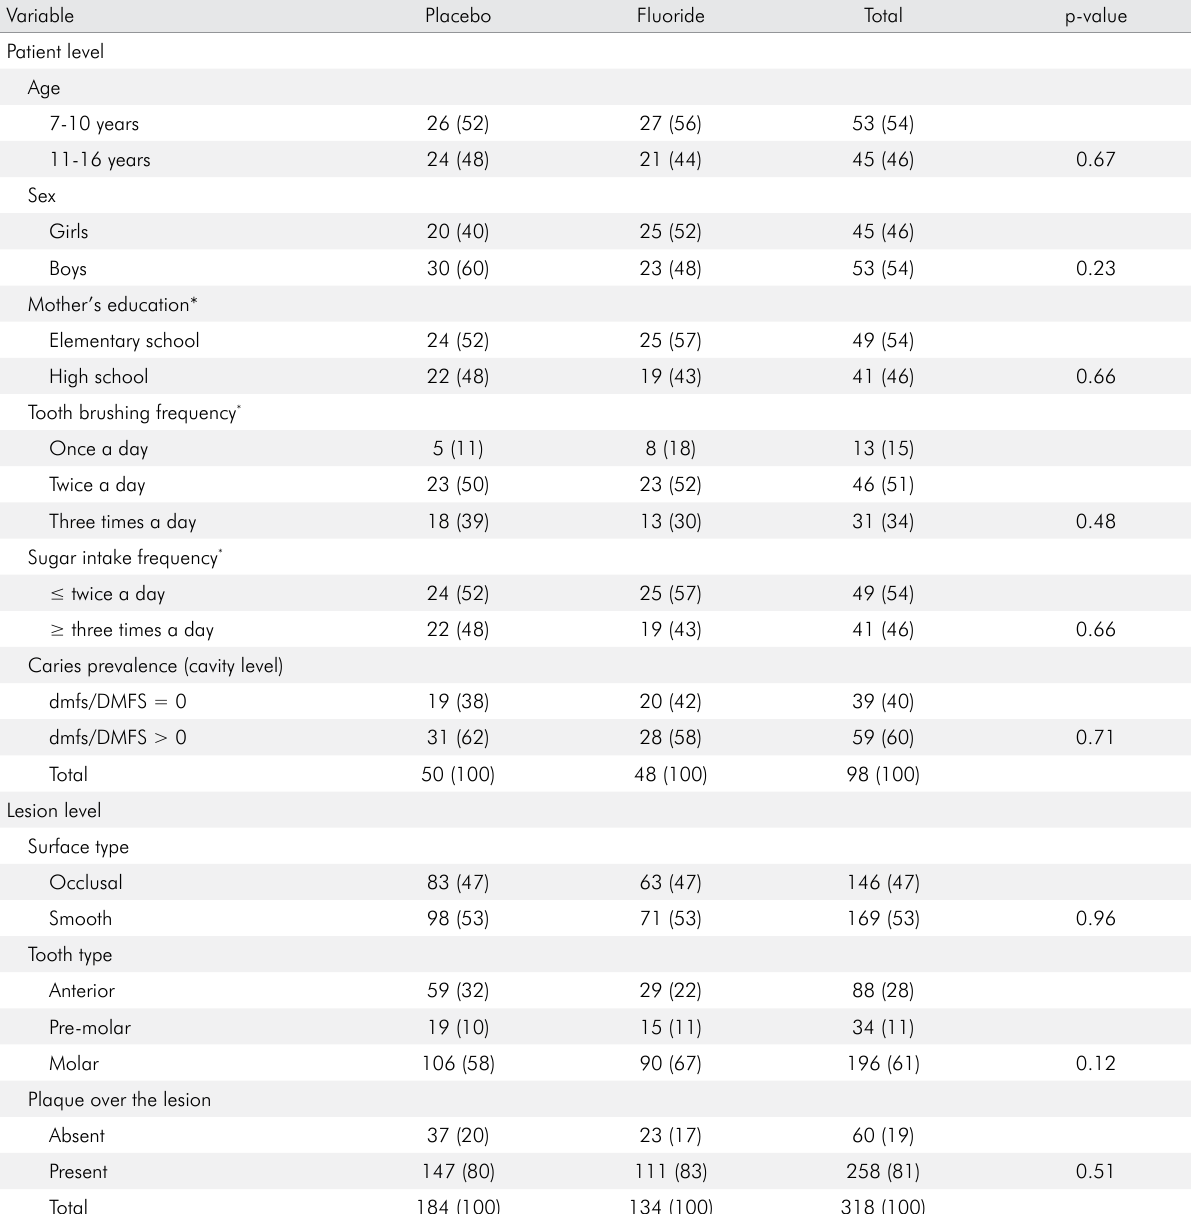
Table 1. Sample description at the patient level and at the lesion level. n (%). Variable